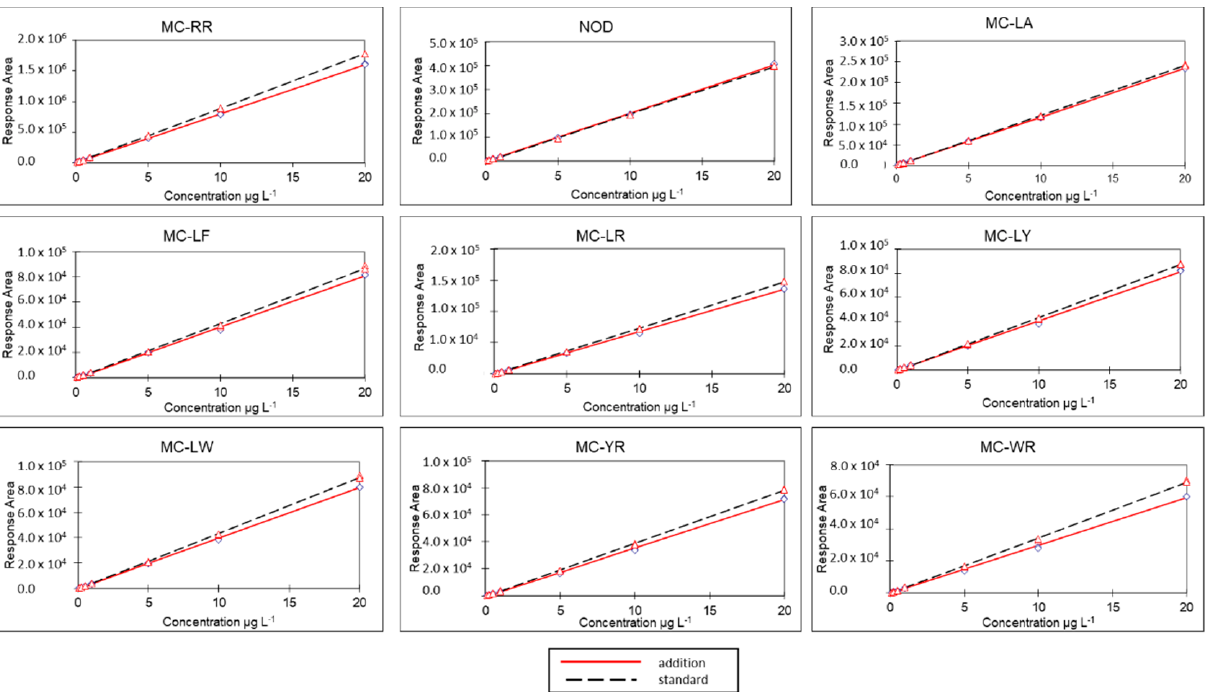
After spiking the water matrix at the same concentrations as the calibration curve, a matrix effect was observed for all toxins based on the difference between the slopes using a t -test (Figure 2 and Table 3). The presence of a matrix effect substantiates the need for a calibration curve in the matrix.